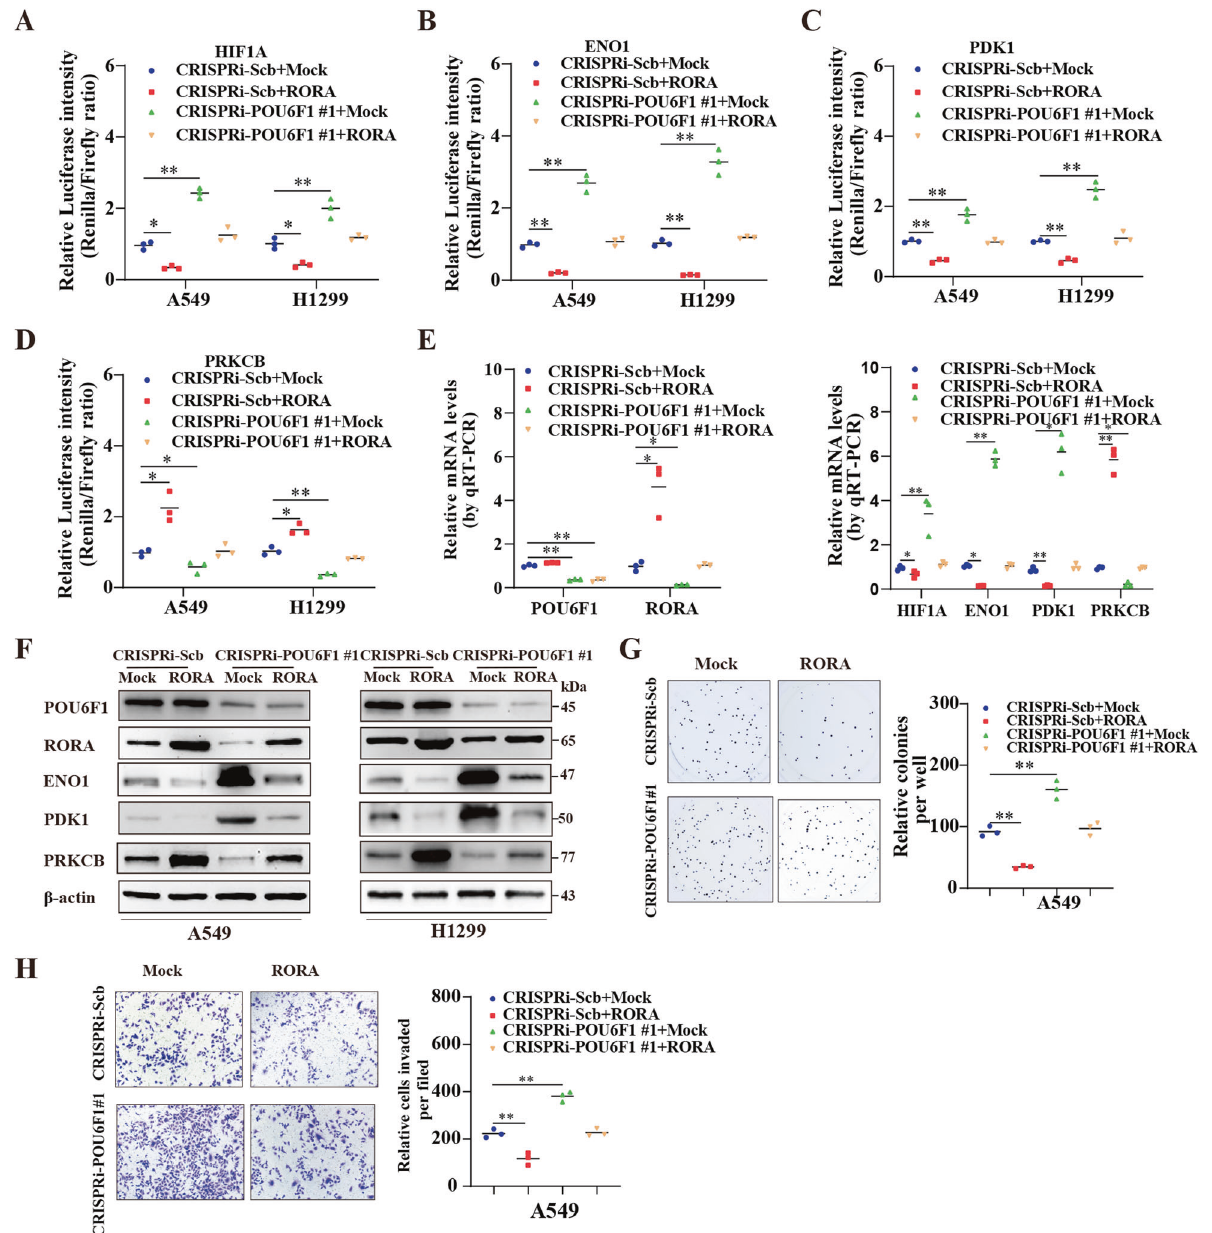
Fig. 7 POU6F1 coordinates with RORA to inhibit LUAD progression. A – D Dual-luciferase assay indicating the relative promoter activity of HIF1A, ENO1, PDK1, and PRKCB in A549 and NCI-H1299 cells transfected with mock, RORA, CRISPRi-Scb, or CRISPRi-POU6F1 #1. E , F Real-time qRT-PCR and western blotting assays showing the expression of POU6F1, RORA, HIF1A, ENO1, PDK1, and PRKCB in A549 cells transfected with mock, RORA, CRISPRi-Scb, or CRISPRi-POU6F1 #1. G , H Representative images (left panel) and quanti fi cation (right panel) of soft-agar ( G ) and transwell ( H ) assays indicating the growth and invasion of A549 cells transfected with mock, RORA, CRISPRi-Scb, or CRISPRi-POU6F1 #1. Student ’ s t -test and ANOVA compared the difference in A – E and G – H . * P < 0.05, ** P <